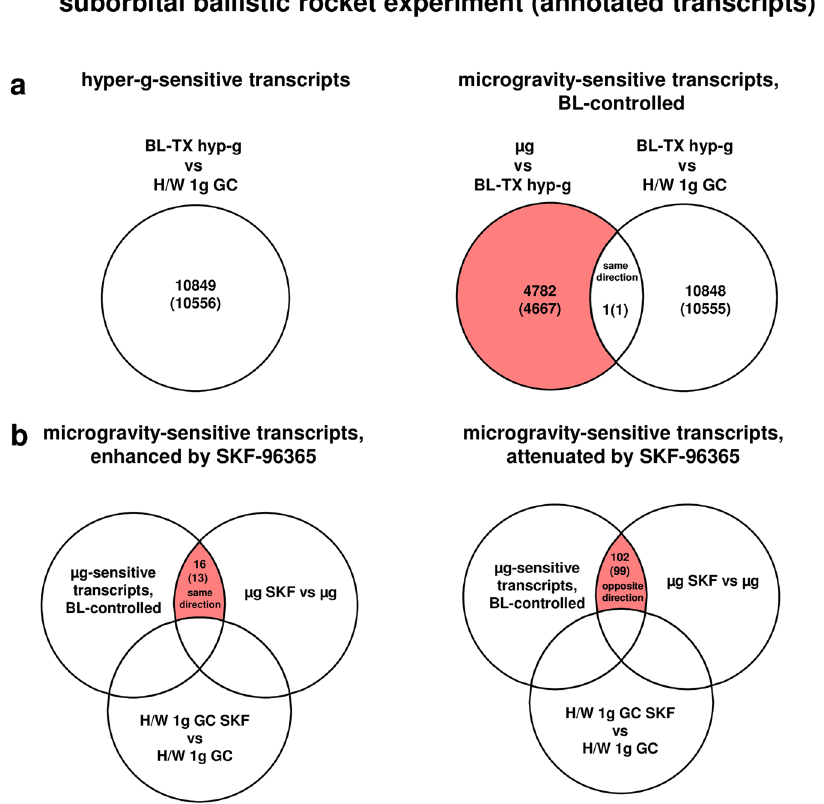
Figure 3. Differentially regulated transcripts (and annotated transcripts) in human U937 myelomonocytic cells during the TEXUS-49 suborbital ballistic rocket campaign. ( a ) The different comparisons and resulting intersections for hypergravity and microgravity-sensitive transcripts are displayed. ( b ) Analysis of the influence of the cation ion channel blocker SKF-96365 on microgravity-regulated gene expression. Fold change ≤− 1.3 and ≥+ 1.3, p < 0.05.